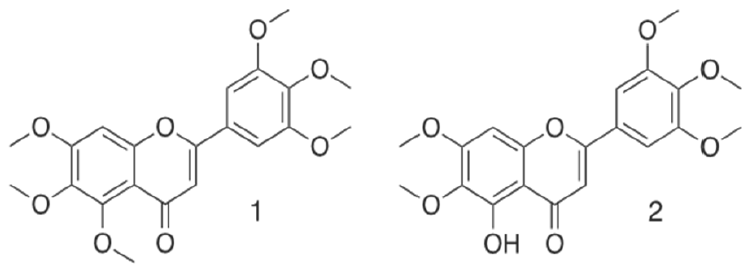
Figure 4. Structural formulas of isolated compounds 5,6,7,3 ′ ,4 ′ ,5 ′‐ hexamethoxy ‐ flavone (1) and 5 ‐ hydroxy ‐ 6,7,3 ′ ,4 ′ ,5 ′‐ pentamethoxyflavone (2) from Lantana ukambensis (Verbenaceae).